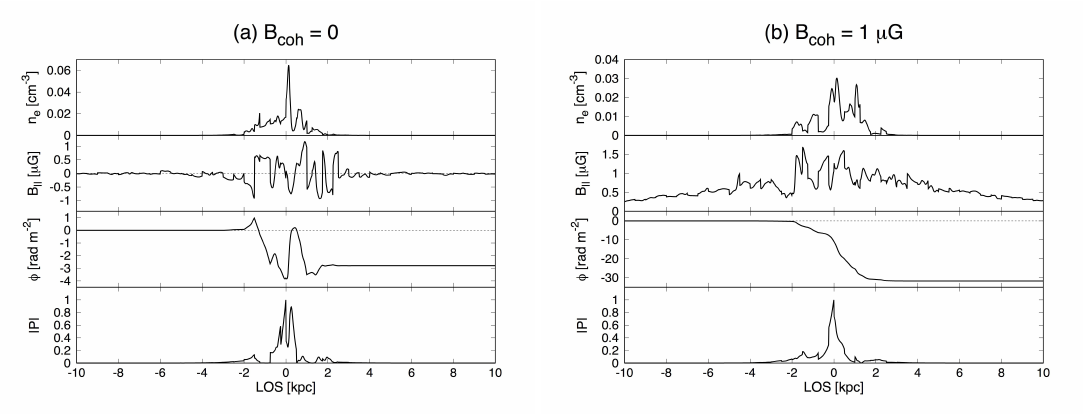
Figure 1. ( a ) LOS ( z -axis) distributions for the “ B coh = 0” case ( left panels) and for the “ B coh = 1 µ G” case ( right panels). Each panel shows the thermal electron density ( n e ), LOS components of the magnetic field ( B (cid:107) ), Faraday depth ( φ ) calculated from n e and B (cid:107) , and absolute polarized intensity ( | P | ), from top to bottom. Note that φ ( − 10 kpc ) = 0 by design, since these are cases where the model is treated as an external